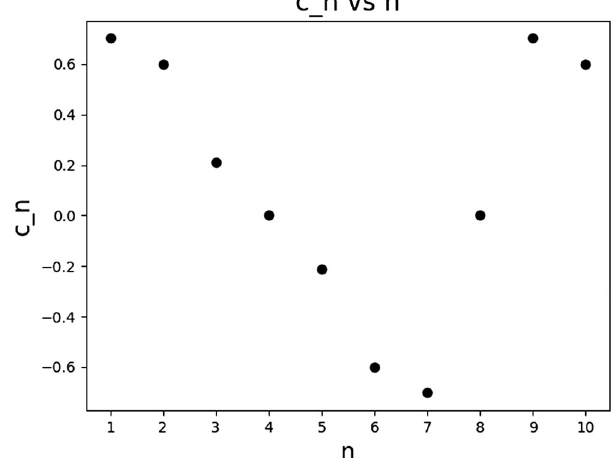
(1981).FIG. 4. The wave function of a particle in a box and an approximation up to the first 10 terms in an energy eigenstate of that wave function with probability density on the vertical axis and position on the horizontal axis.